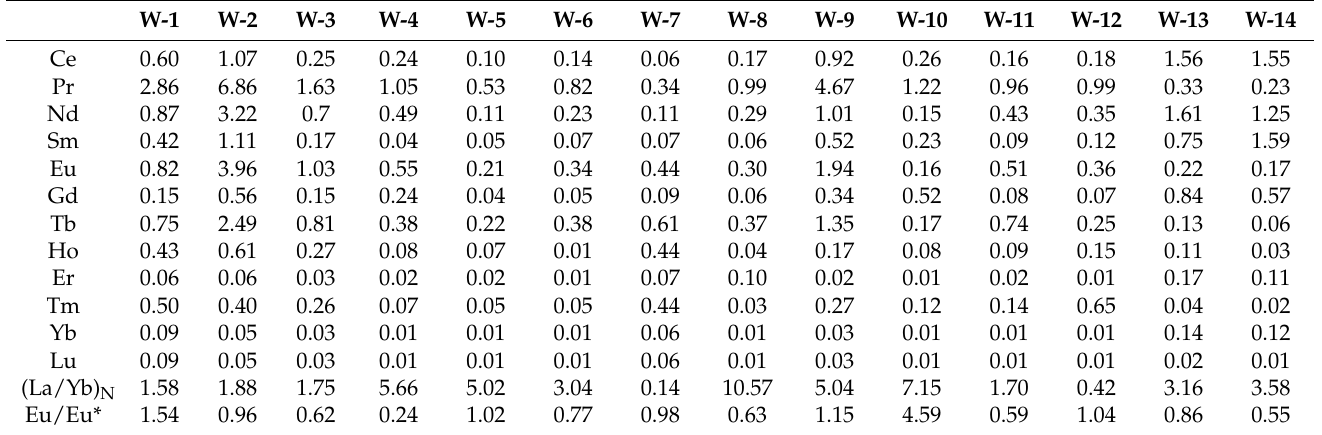
Table 6. Qing dynasty jadeite rare earth elements (ppm).